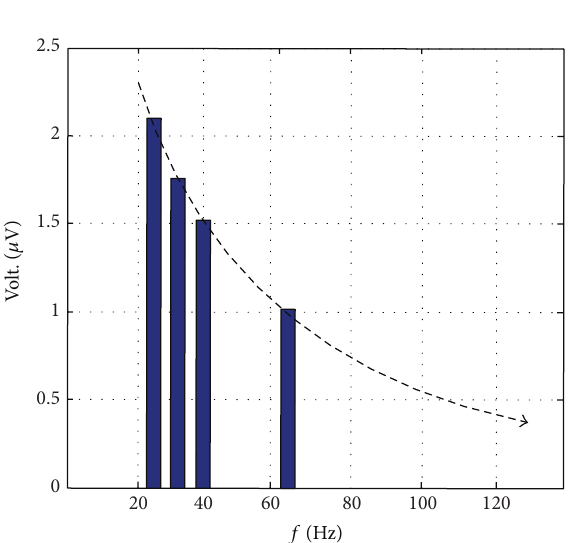
Figure 4: The fitted curve of FFT